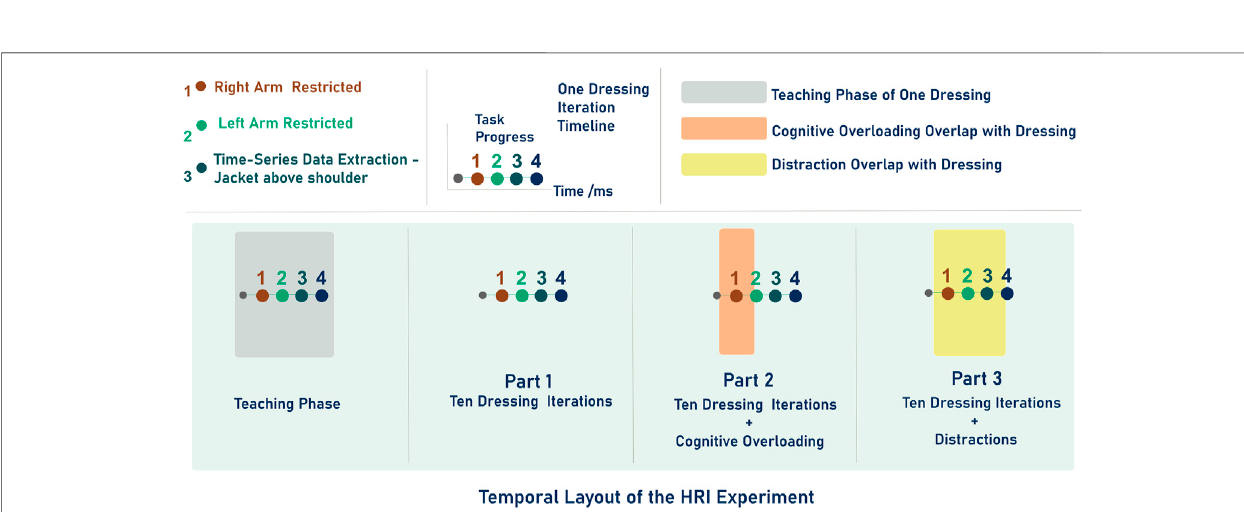
FIGURE2| Overallexperimenttimelineaftermarkerone:1)teachingphasefollowedbyPart1madeoftendressingtasks,2)Part2consistingoftendressingtasks with cognitive overloading and 3) Part 3 again consisting of ten dressing tasks with distractions . Markers from one to four represent the same instances in the dressing task as shown in Figure 1